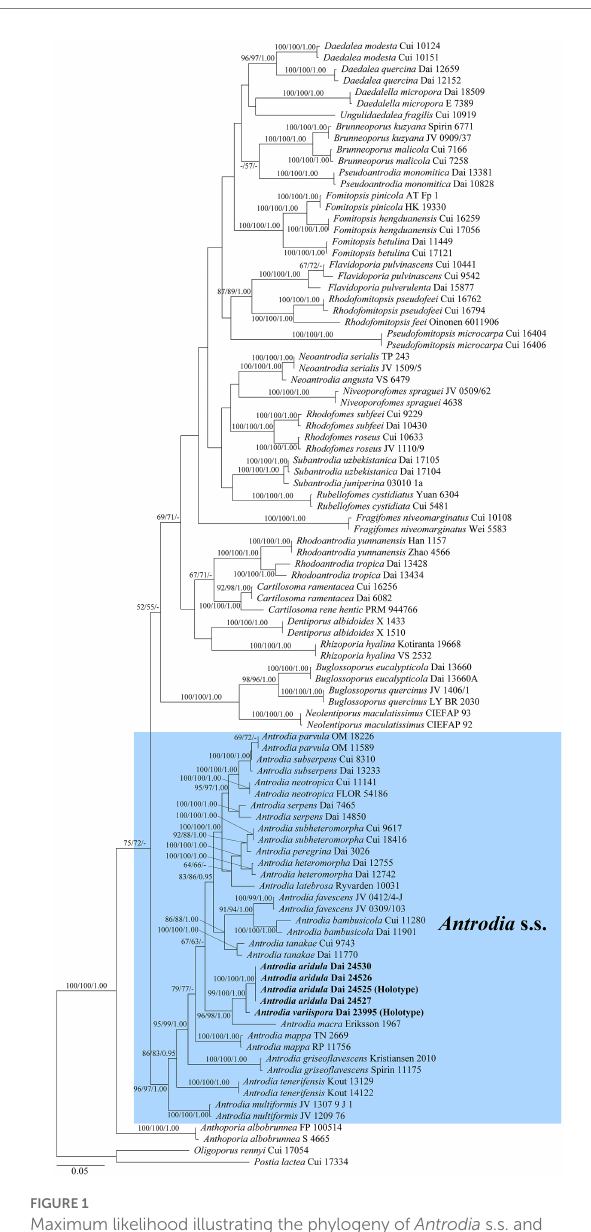
FIGURE 1 Maximum likelihood illustrating the phylogeny of Antrodia s.s. and related genera based on ITS + nLSU + nSSU + mtSSU + TEF1 + RPB2. Branches are labeled with parsimony bootstrap proportions and maximum likelihood bootstrap higher than 50%, and Bayesian posterior probabilities more than 0.95, respectively.